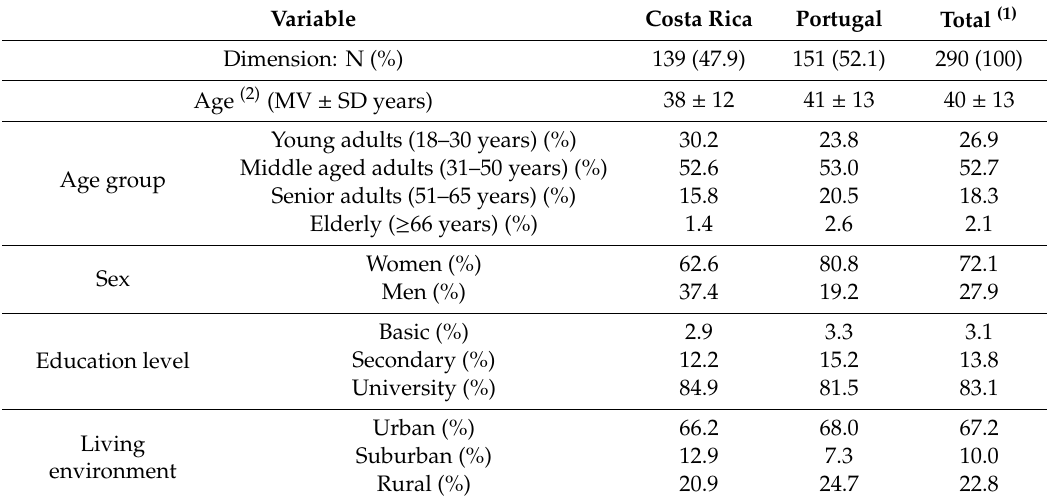
Table 1. Sociodemographic characterization of the study sample.